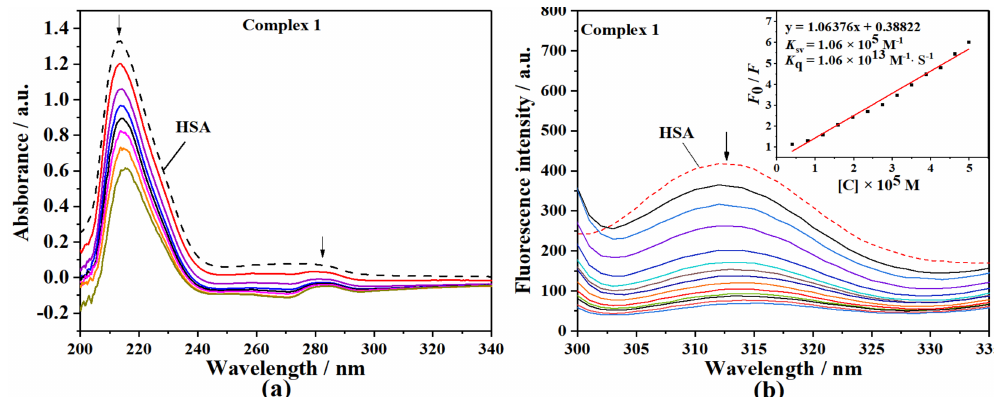
Figure 6. HSA electronic absorption spectra with and without complex 1 ( a ). HSA platform emission spectra with and without complex 1 ( b ). Inset: F 0 / F vs. [C] plot. Arrows illustrate the intensity changes with increasing complex quantity.